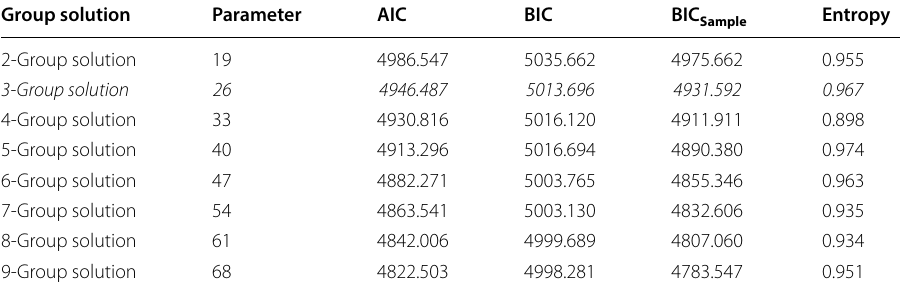
Table 5 Summary of the model fit of the LPAs with different numbers of school profiles (selected group solution highlighted in italics)